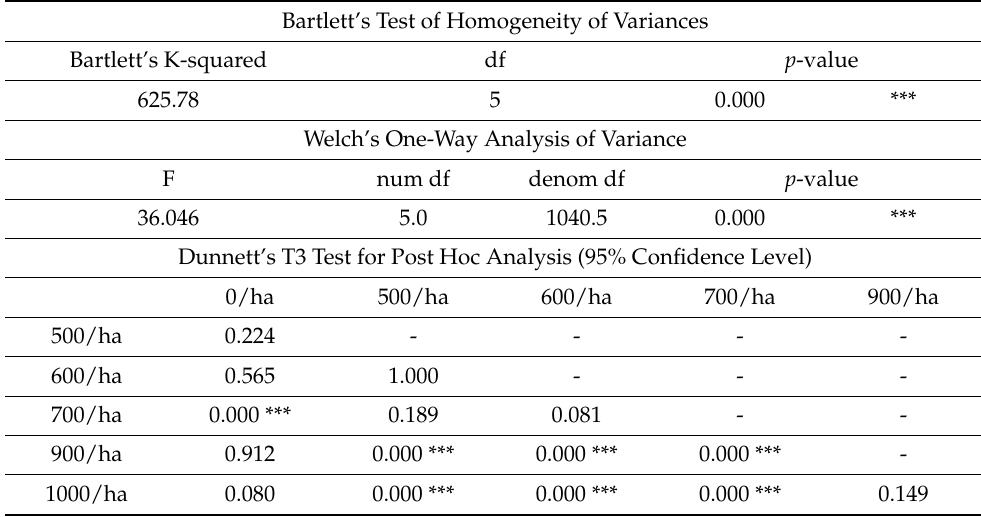
Table 3. Results of one-way analysis of variance of NVOCs and forest density. Bartlett’s Test of Homogeneity of Variances Bartlett’s